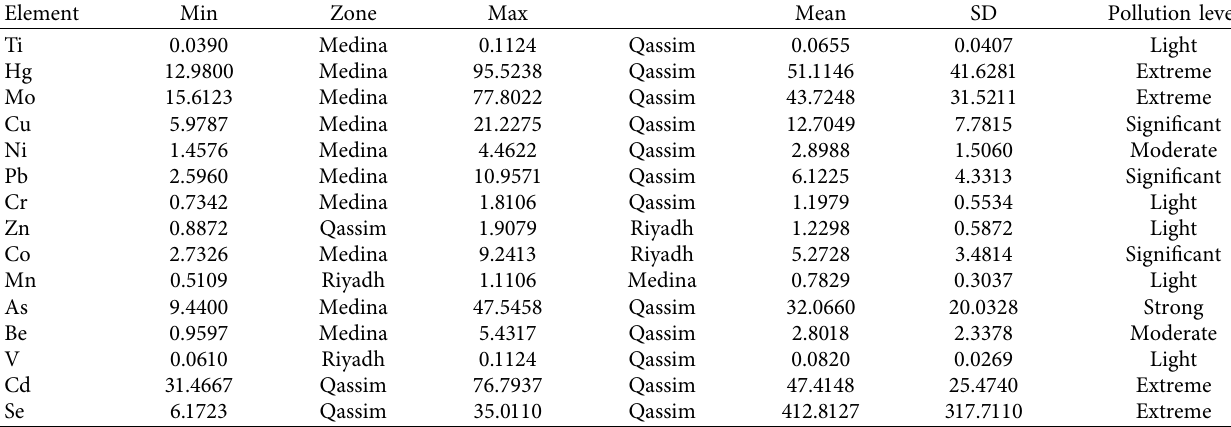
Table 4: Results of enrichment factor at soil of Riyadh, Qassim, and Medina regions treated with sewage water. Element